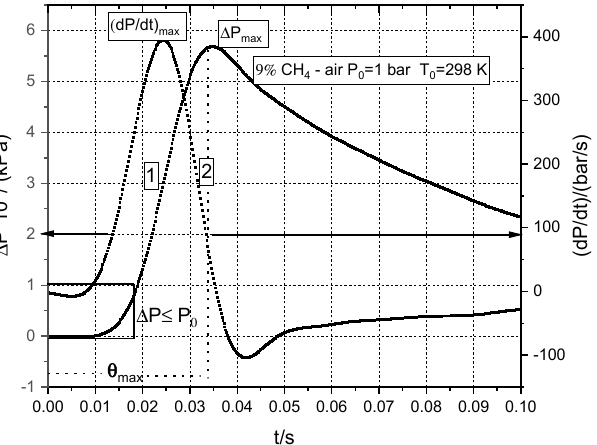
Figure 2. An illustration of the experimental pressure–time curve, Δ P–t , its calculated derivative (d P /d t )– t and resulted characteristic parameters Δ P max (curve 1) and (d P /d t ) max (curve 2), θ max . The initial pressure rise for Δ P ≤ P 0 is shown on the lower left side.